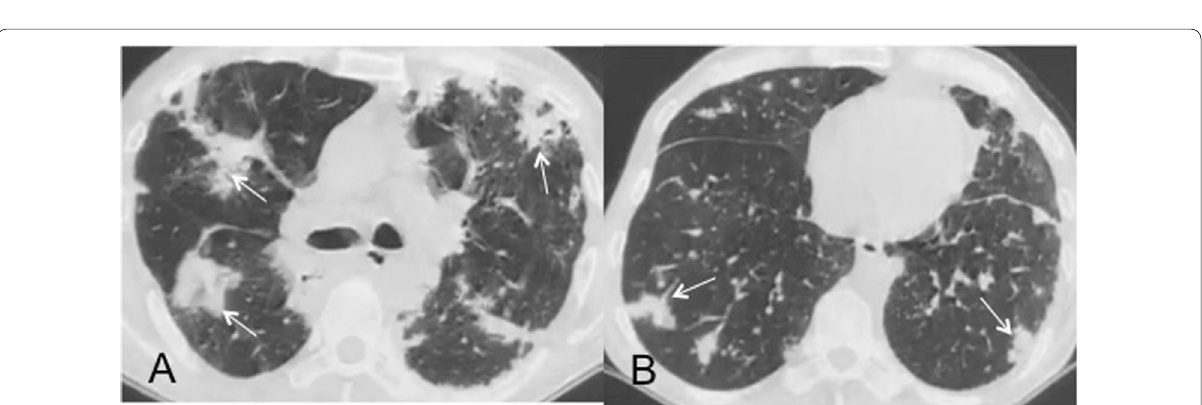
Fig. 2 Bilateral confluent fibrotic changes with consolidations (white arrows) in a patient 21 days after